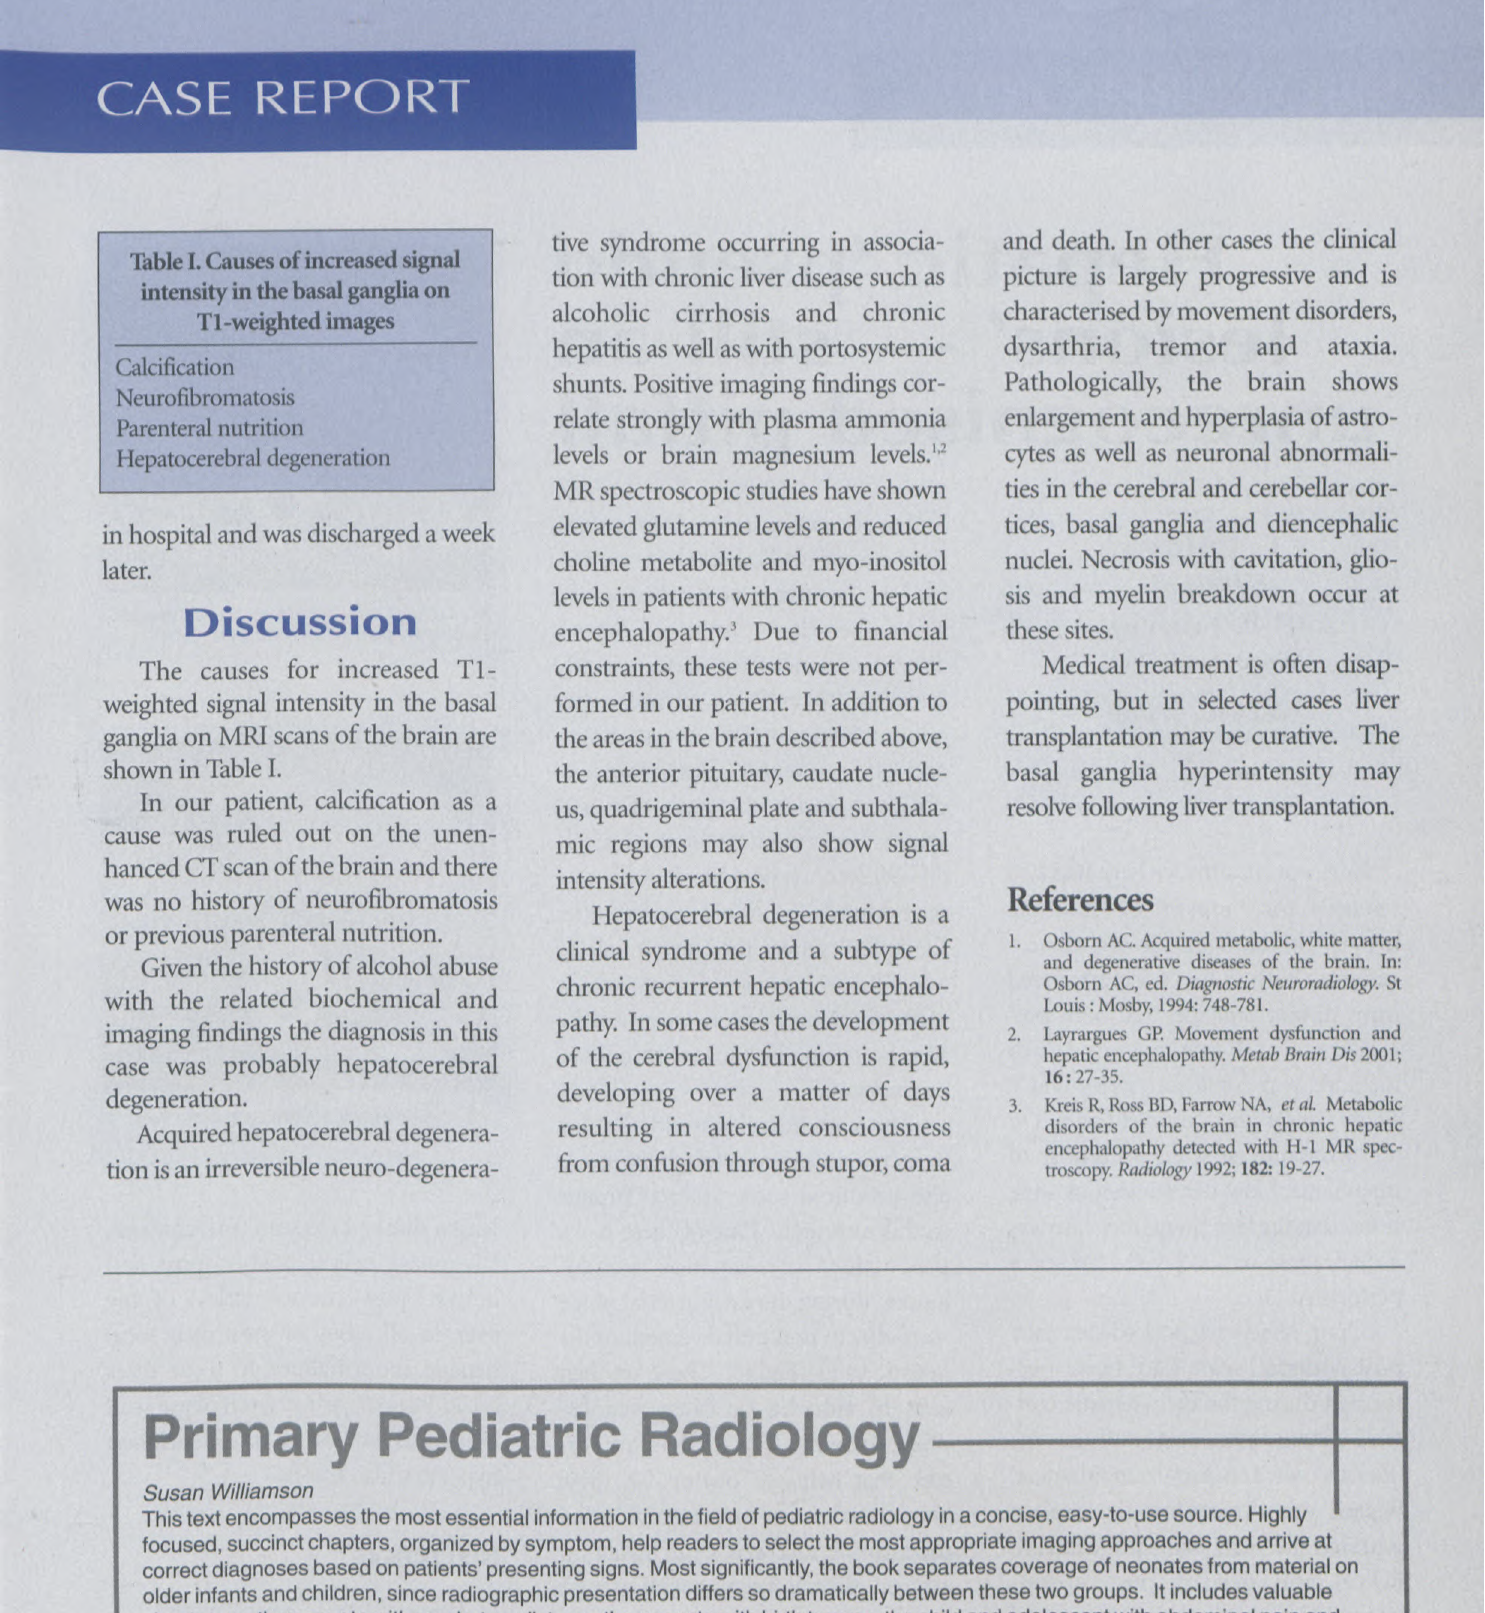
Table I. Causes of increased signal intensity in the basal ganglia